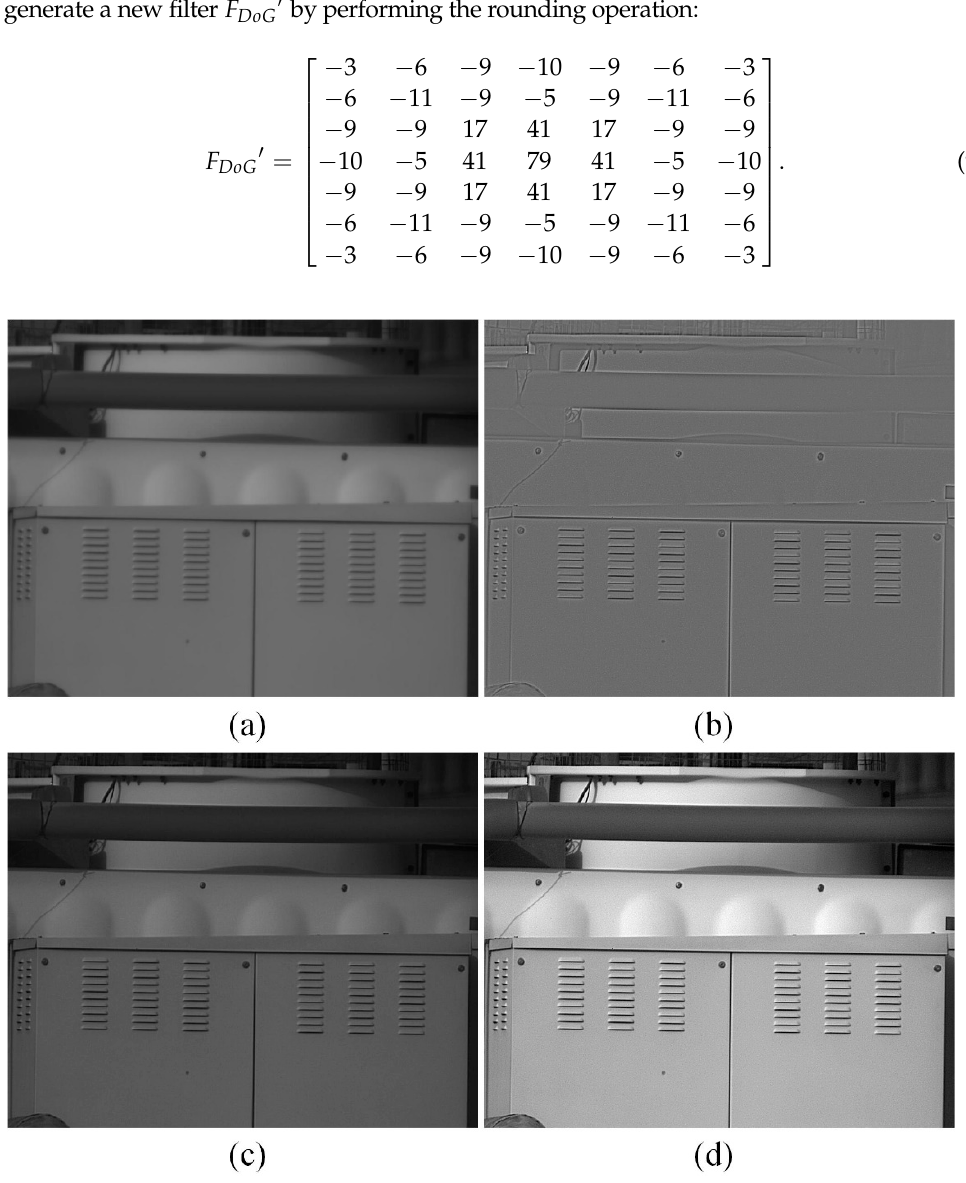
Figure 3. Images of different procedures: ( a ) input image, ( b ) detail image, ( c ) sharpened image with gain of 15, and ( d ) the output image with PE processing.